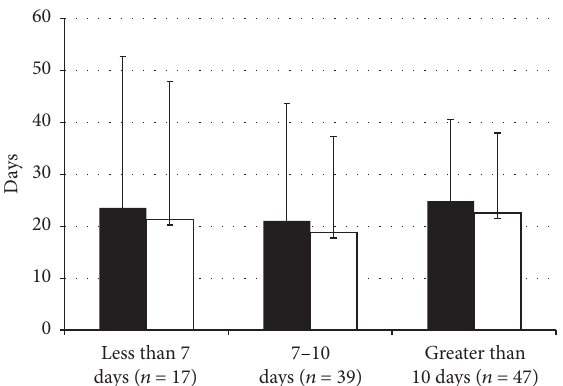
Figure 6: ICU length of stay and duration of mechanical ventilation relatedtolengthofantibiotictherapyinGroupIbacteria.ICUlength of stay ( ◼ ) and duration of mechanical ventilation duration ( ◻ ) in patients treated with less than 7 days, 7 to 10 days, and greater than 10 days of antibiotic therapy for Group I bacteria. There were no significant differences in ICU length of stay ( 𝑝 = 0.71 ) or duration of mechanical ventilation ( 𝑝 = 0.65 ) among the duration groups. Data presented as mean ± standard